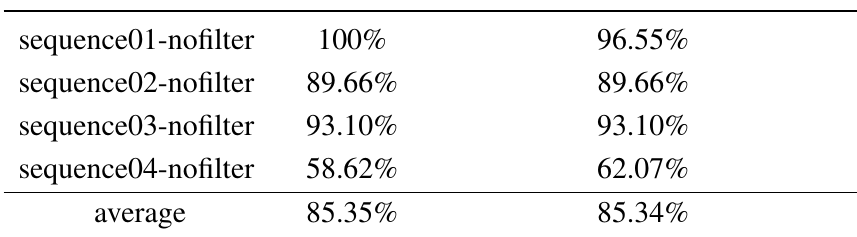
Table 8. The mean value of correct first detections without the optical filter in the linebreak indoor